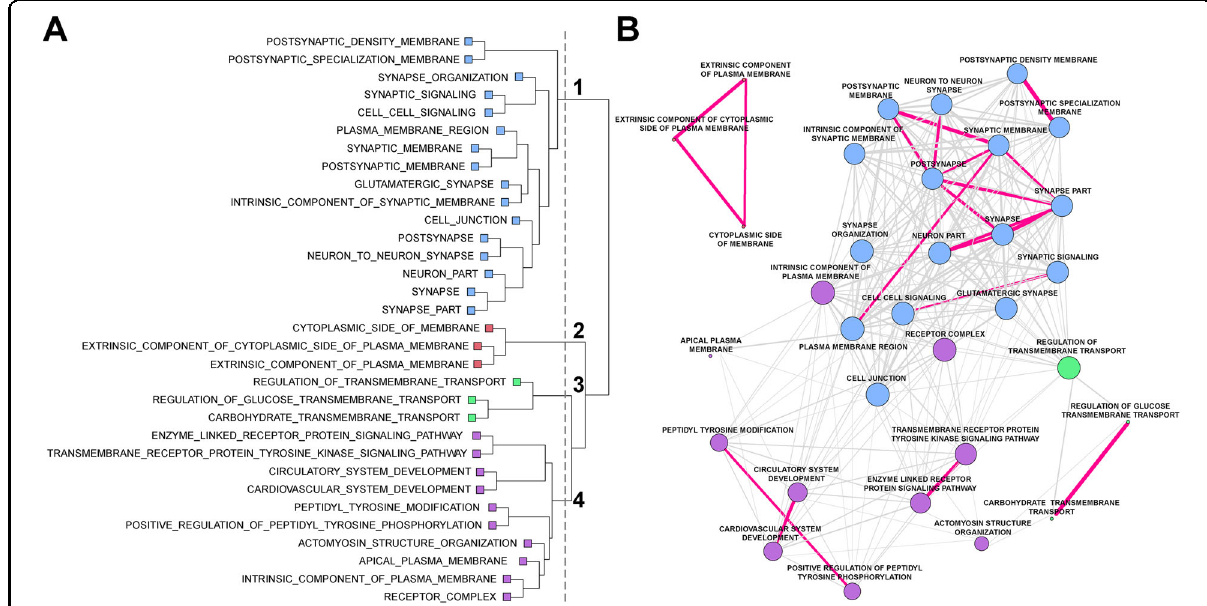
Fig. 2 Gene set enrichment analysis for obsessive-compulsive disorder (OCD). Following RNA sequencing, global differentially expressed genes were determined between OCD subjects and unaffected comparison subjects (904 genes). Signi fi cant gene sets from the gene ontology (GO) pathways were determined using Fisher ’ s exact test. A Gene co-occurrence cluster dendrogram for gene set enrichment in OCD. Following gene set enrichment analysis, the number of co-occurring genes among the GO pathways were assessed. Four main branches were identi fi ed on the basis of the cut-point (vertical gray dashed line) established by visual inspection and color-coded per branch (blue: cluster 1; red: cluster 2, green: cluster 3, purple: cluster 4). B Cluster plot of gene sets associated with OCD. Genes were assessed using hierarchical clustering on the distances computed per gene set. The edges (lines) connecting nodes indicate the number of co-occurring OCD genes, where magenta lines have at least half of the genes co-occurring between the nodes (gene pathways), and gray lines indicate less than half of the OCD genes were co-occurring. Co-occurring genes were de fi ned as the fraction of genes present in two pathways given the total number of unique genes represented in both pathways. The thickness of the magenta lines indicates more (thicker) or less (thinner) gene co-occurrence between two given gene sets. Note, the length of connecting vertices does not indicate distance between